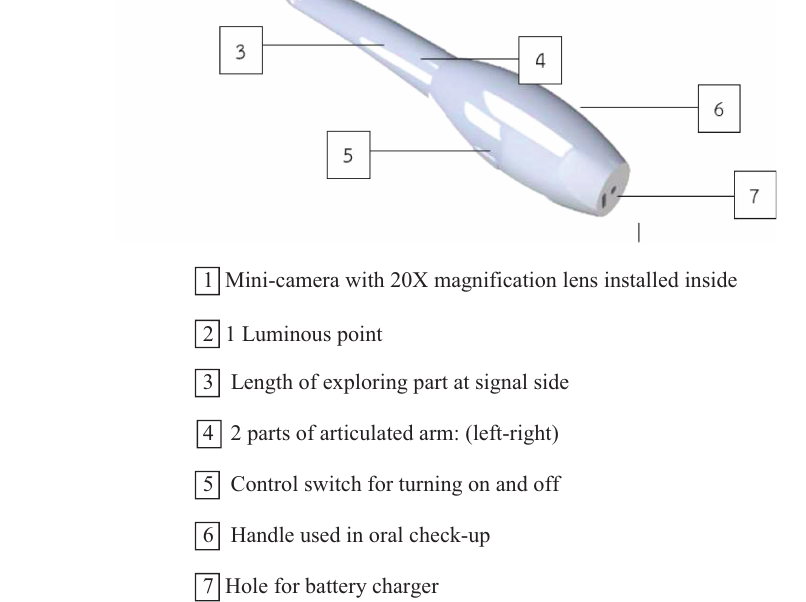
Figure 1. Smartphone